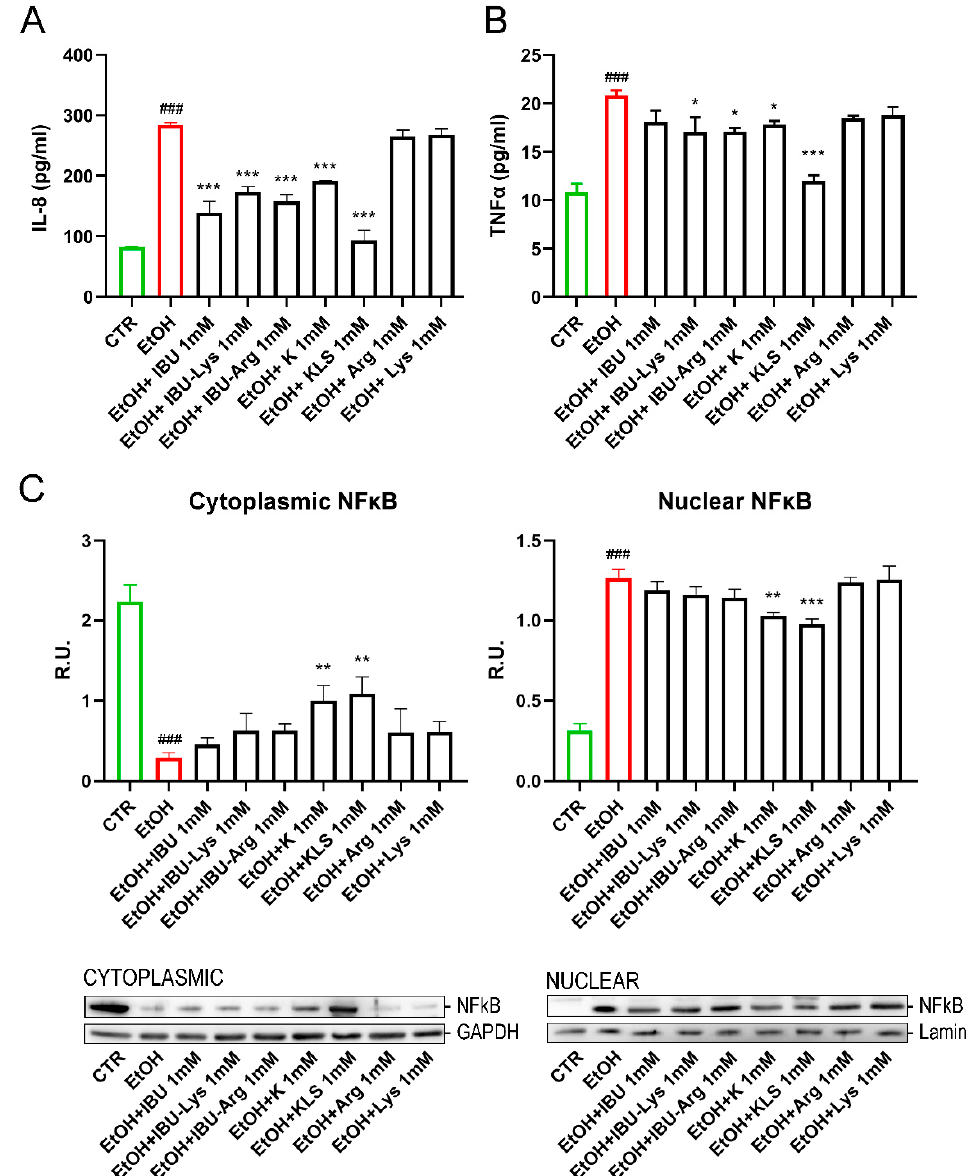
Figure 3. ( A ) Secreted levels of IL-8 on Caco-2 cells after EtOH (6% for 24 h), EtOH + IBU, EtOH + IBU-Lys, EtOH + IBU-Arg, EtOH + K, EtOH + KLS, EtOH + Arg, and EtOH + Lys treatments (1 mM) for 72 h by ELISA assay. ( B ) Secreted levels of TNF α on Caco-2 cells after EtOH (6%, for 24 h), EtOH + IBU, EtOH + IBU-Lys, EtOH + IBU-Arg, EtOH + K, EtOH + KLS, EtOH + Arg, and EtOH + Lys treatments (1 mM) treatments for 72 h by ELISA assay. Data are mean ± SD of 3 different experiments. ( C ) WB analysis for cytoplasmic and nuclear components of NF κ B on Caco-2 cells after EtOH (6%, for 24 h), EtOH + IBU, EtOH + IBU-Lys, EtOH + IBU-Arg, EtOH + K, EtOH + KLS, EtOH + Arg, and EtOH + Lys treatments (1 mM) for 72 h. Data are mean ± SD of 3 different experiments. One way ANOVA was performed: ***, p < 0.0001; **, p < 0.005; *, p < 0.05 vs. EtOH; ###, p < 0.0001 EtOH vs.